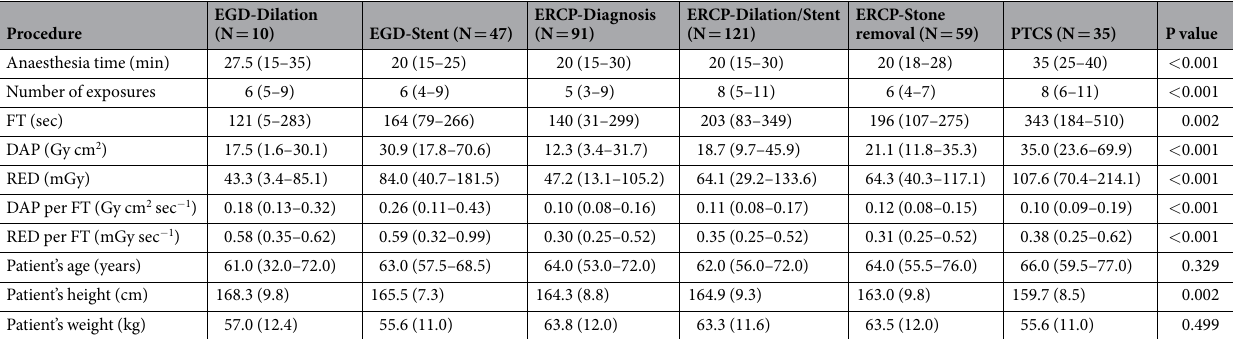
Table 1. Procedural radiation environments in the endoscopic retrograde cholangiopancreatography (ERCP) room. Values are presented as median (IQR) or mean (SD). FT, fluoroscopy time; DAP, dose area product; RED, radiation entrance dose; EGD, esophagogastroduodenoscopy; PTCS, percutaneous transhepatic choledochoscopic stone removal. N is the number of procedures. The P value denotes the probability that the quantity median for each procedure belongs to the same distribution.